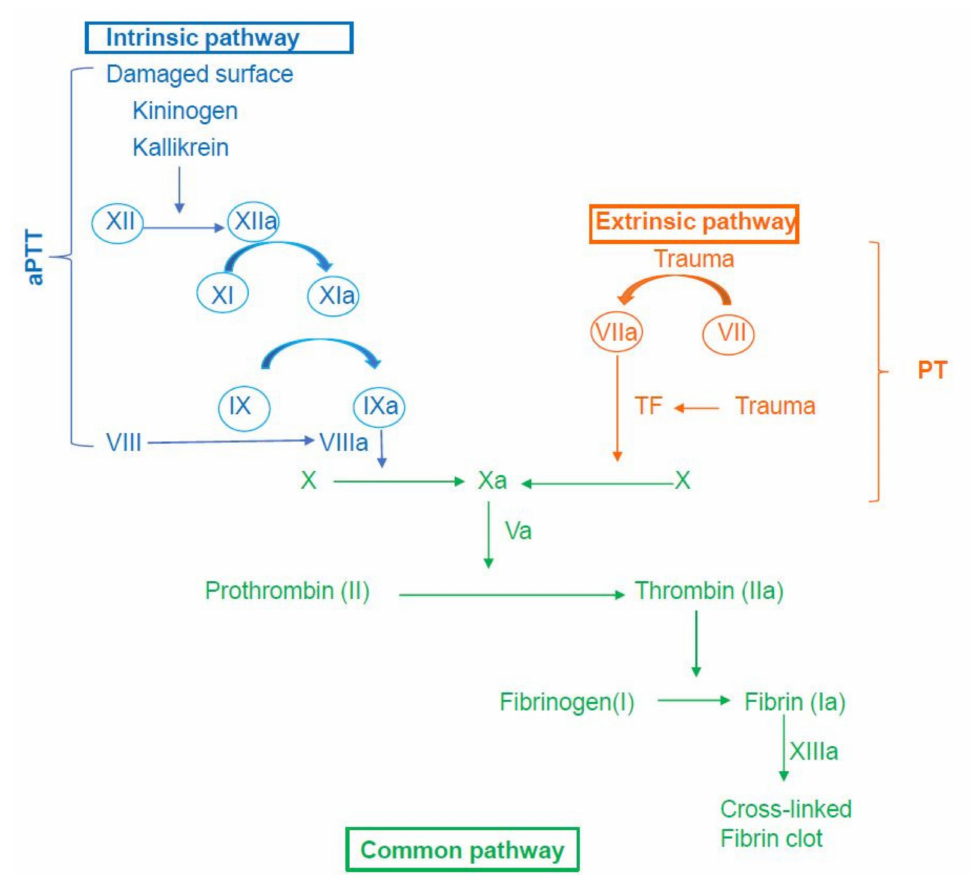
Figure 1. Summary of the coagulation cascade. aPTT: activated Partial Thromboplastin Time; PT: Prothrombin Time; TF: Tissue